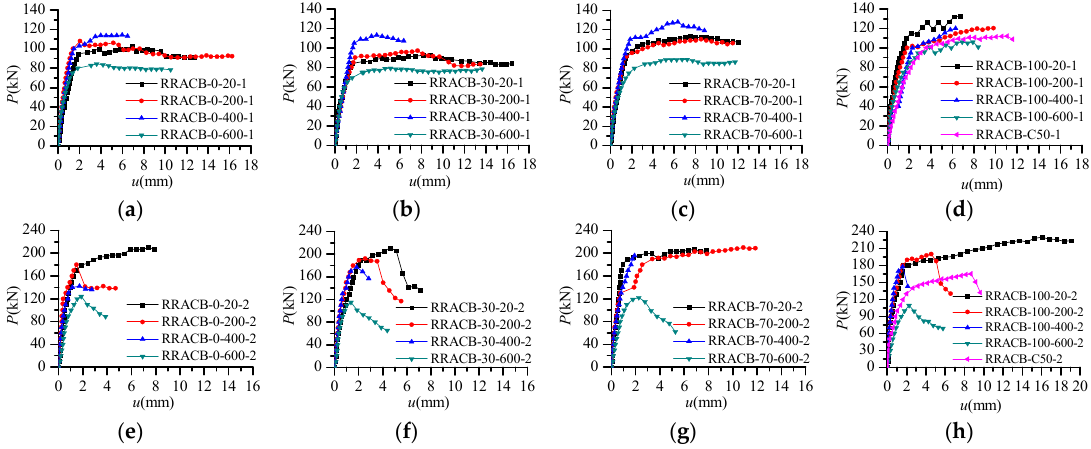
Figure 12. Load-deflection curves of RRAC beams. ( a ) λ = 2.0, r = 0%; ( b ) λ = 2.0, r = 30%; ( c ) λ = 2.0, r = 70%; ( d ) λ = 2.0, r = 100%; ( e ) λ = 1.2, r = 0%; ( f ) λ = 1.2, r = 30%; ( g ) λ = 1.2, r = 70%; ( h ) λ = 1.2, r = 100%.